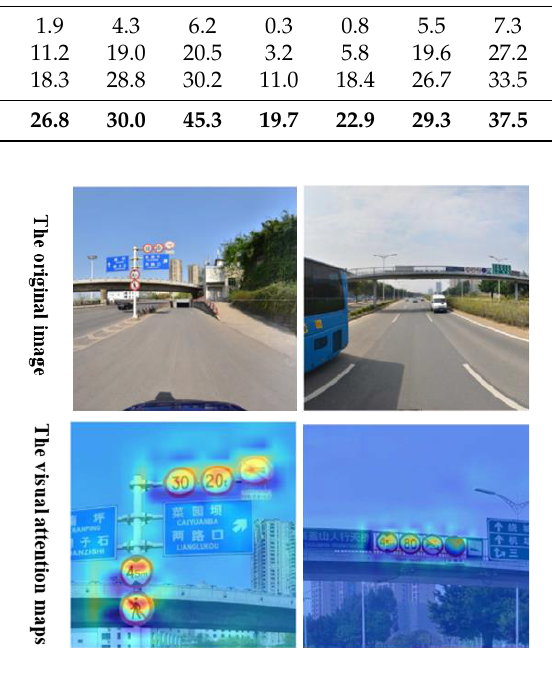
Figure 5. Visualization of attention maps. With feature decorrelation module introduced, clear responses for classes are observed, manifesting this module’s effectiveness in promoting generalization of meta-learned representations. Table 3. Few-shot performance on GTSDB test set for novel classes. For the novel categories, we analyze performance for various numbers of training